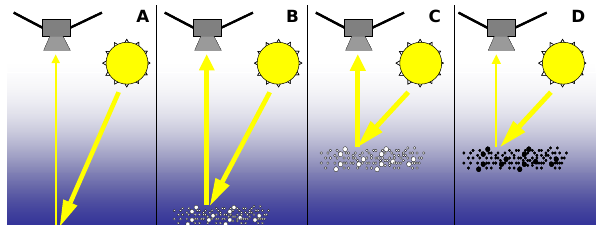
Fig. 1 Basic effects of aerosols on the atmospheric radiative transfer. Albedo effect: compared Fig. 1. Basic effects of aerosols on the atmospheric radiative trans- to an aerosol-free atmosphere (A), in the presence of aerosols the effective earth’s albedo is increased leading to a higher probability of the observed photons to have ‘seen’ the lower fer. Albedo effect: compared to an aerosol-free atmosphere (A) , atmosphere (B). Shielding effect: additional scattering by aerosols causes a reduction of the in the presence of aerosols the effective earth’s albedo is increased light path lengths below the aerosol layer (C). In contrast to clouds, aerosols with single scattering <1 may also absorb a substantial fraction of the solar photons (D). leading to a higher probability of the observed photons to have “seen” the lower atmosphere (B) . Shielding effect: additional scat- tering by aerosols causes a reduction of the light path lengths be- low the aerosol layer (C) . In contrast to clouds, aerosols with single scattering < 1 may also absorb a substantial fraction of the solar photons (D)